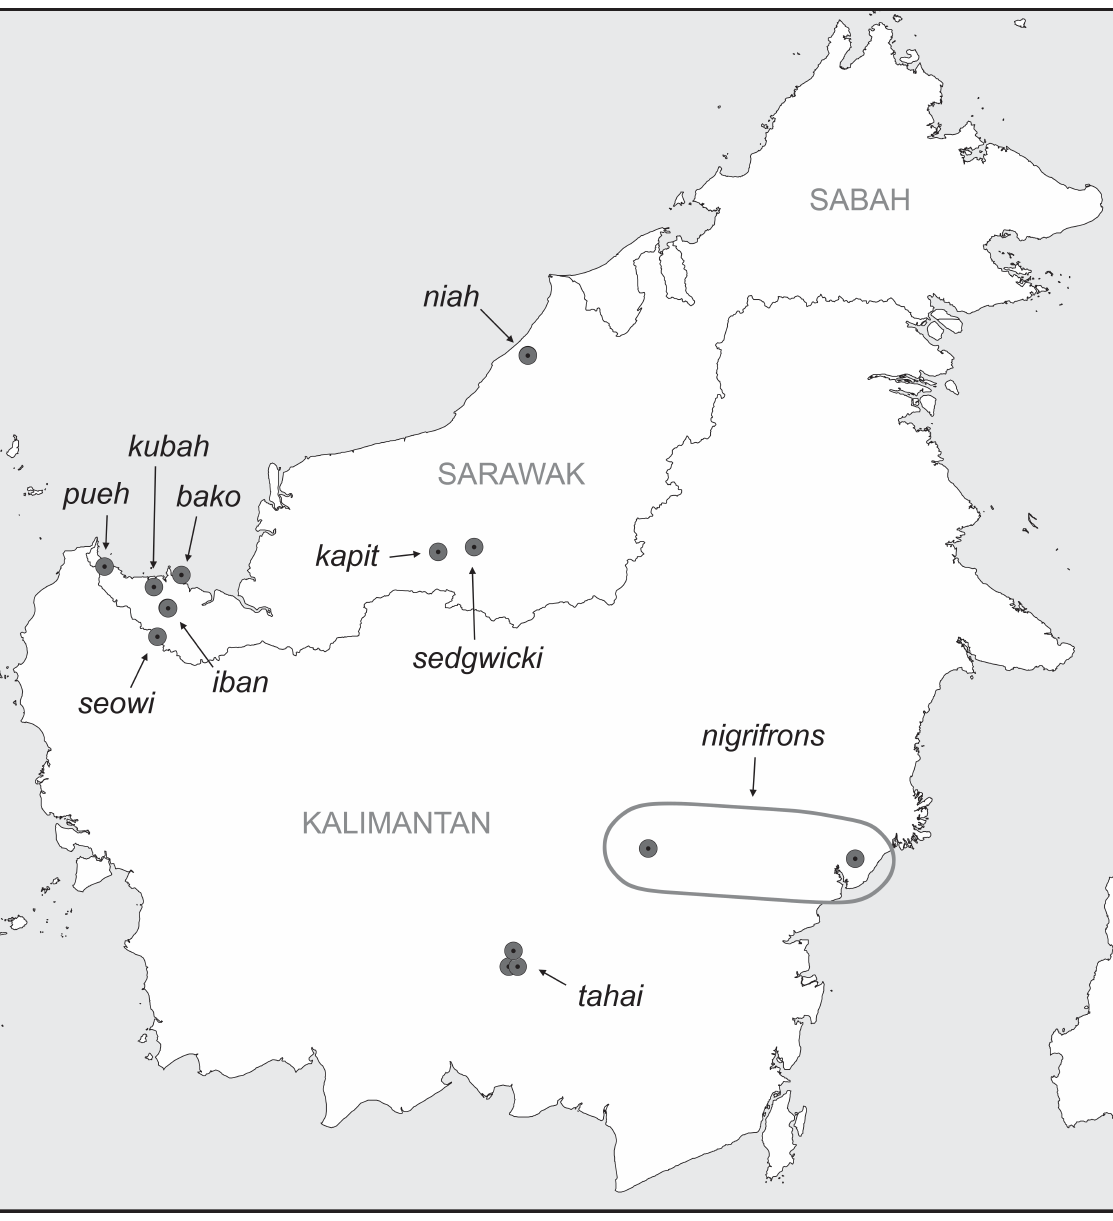
Fig. 1. Known distribution of the Panjange nigrifrons